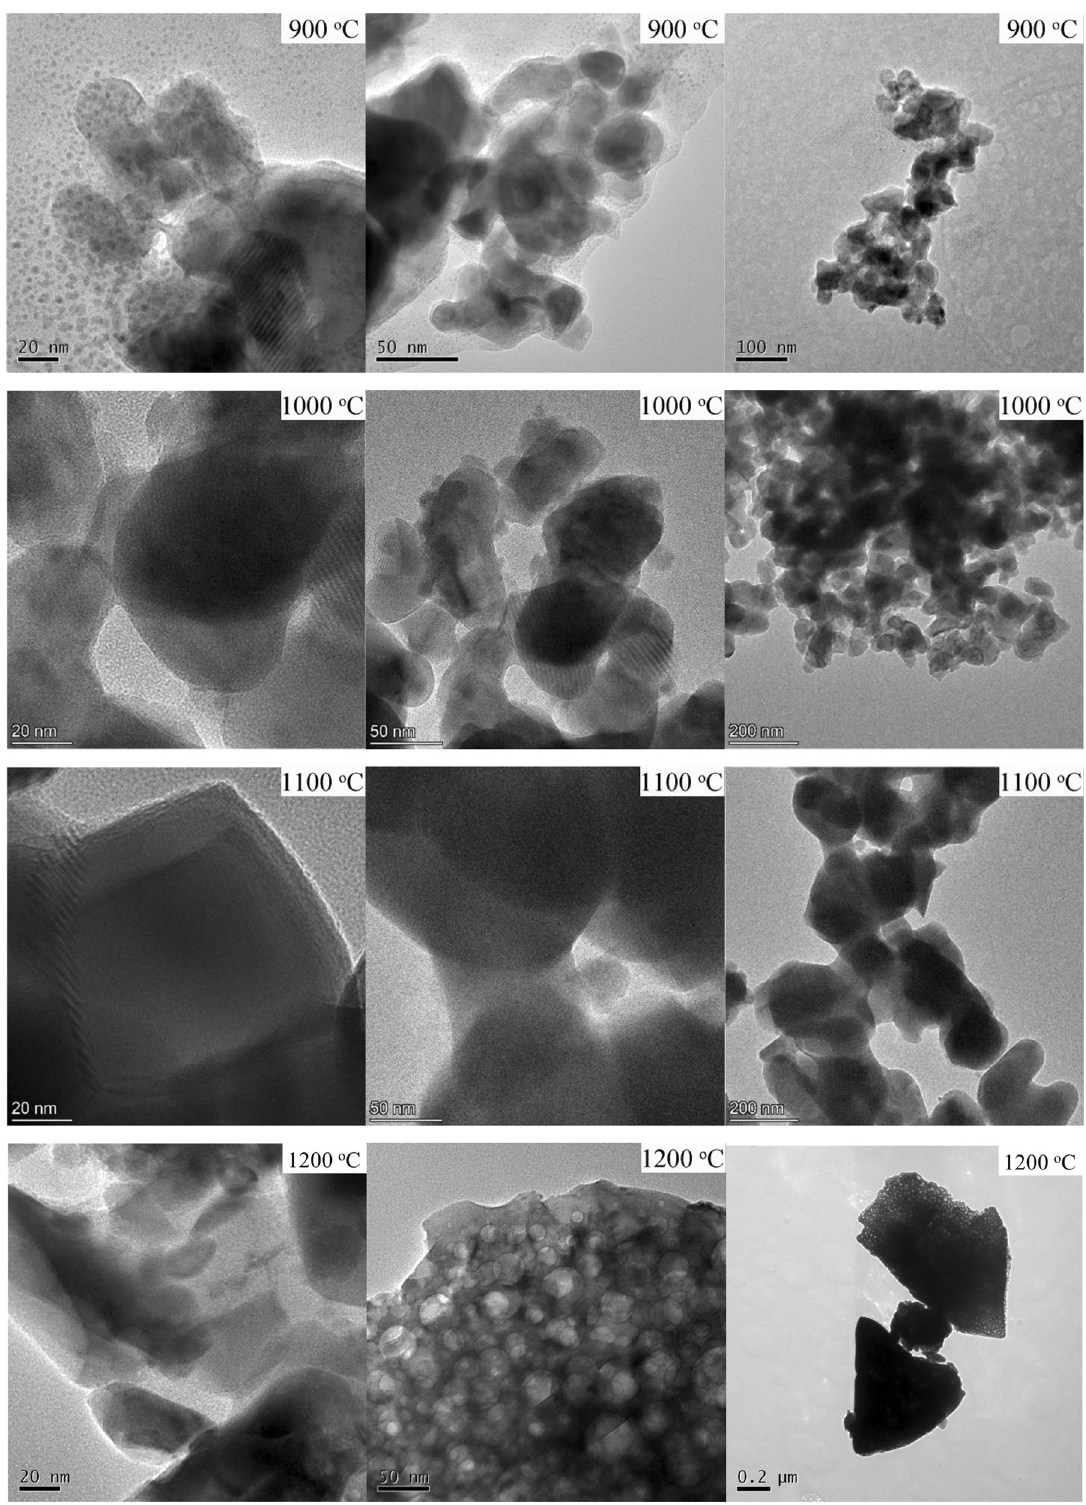
Figure 2. TEM micrographs at different magnifications of the YAGG:Ce 3+ ,Cr 3+ ,Pr 3+ nanophosphors annealed at different